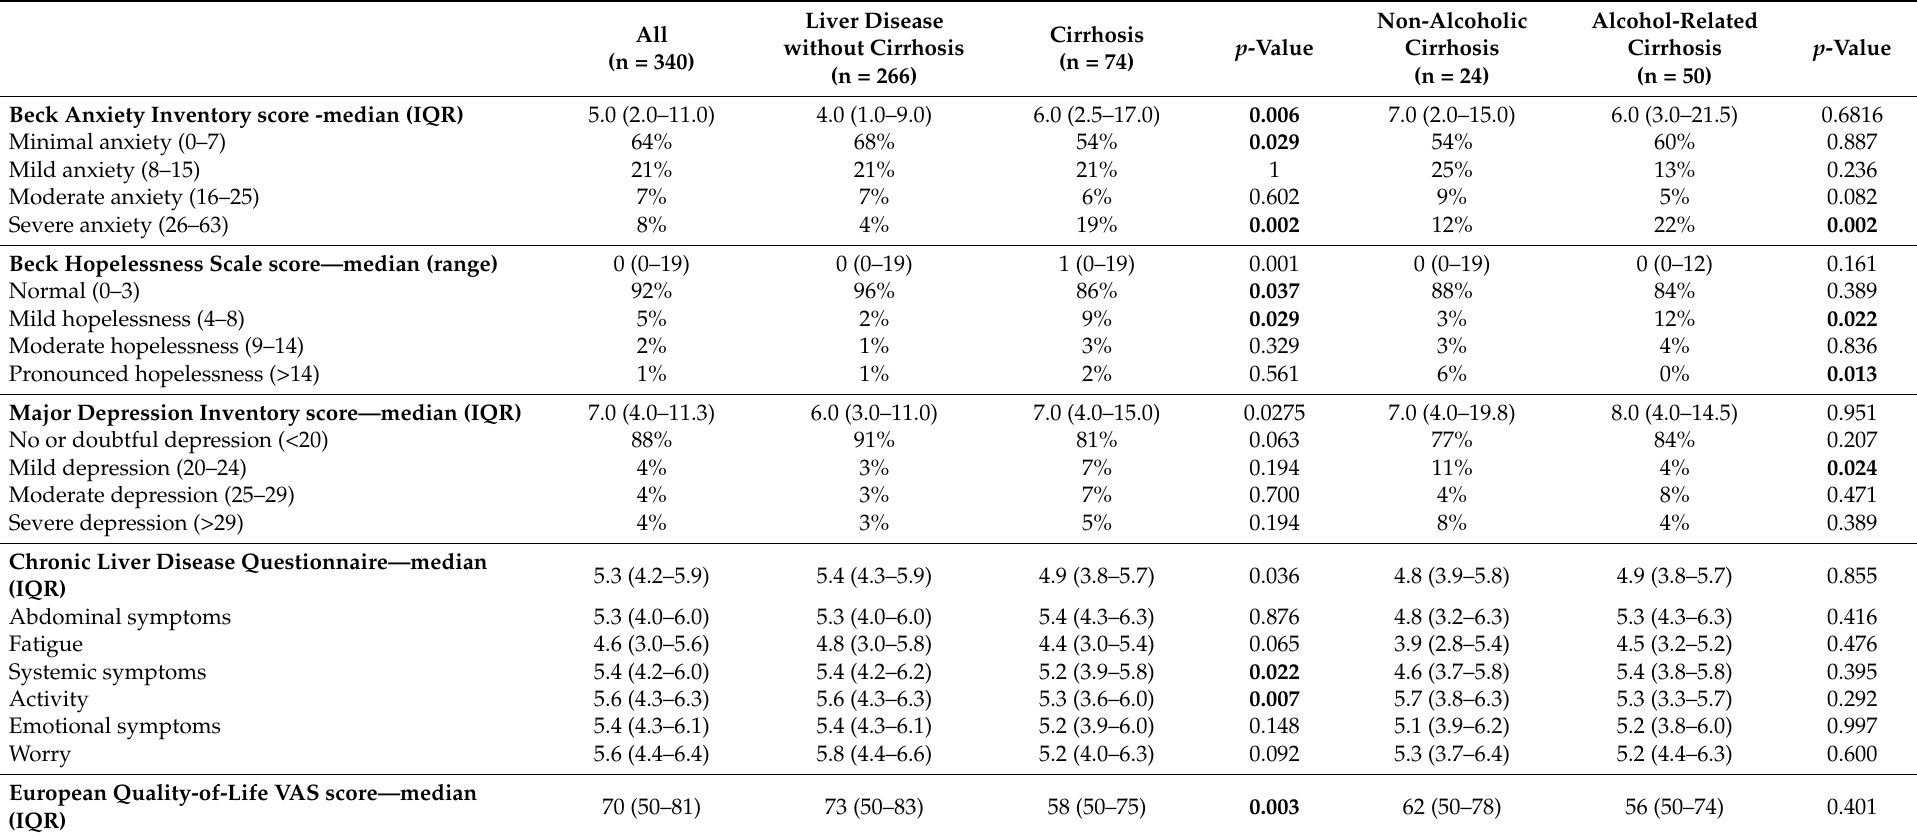
Table 3. Assessment of mental